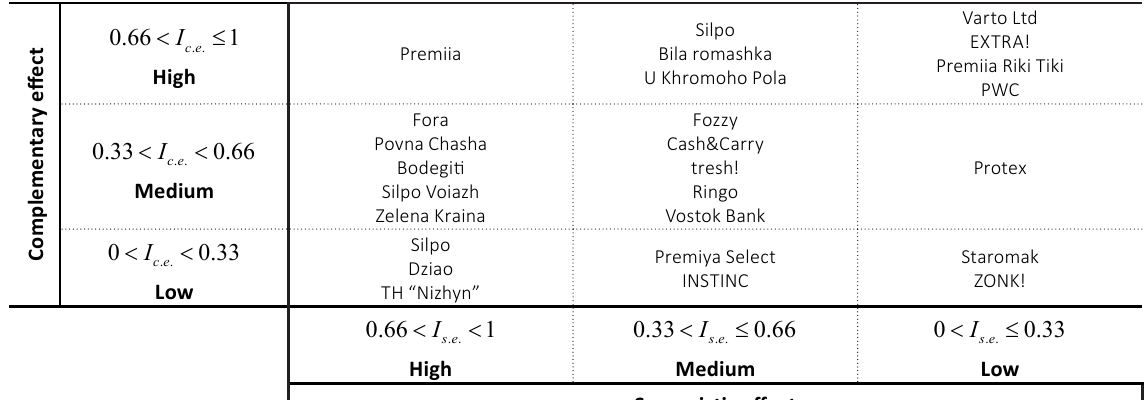
Table 7. Brand classification matrix for the Fozzy Group business units, subject to the level of complementary and synergistic effects